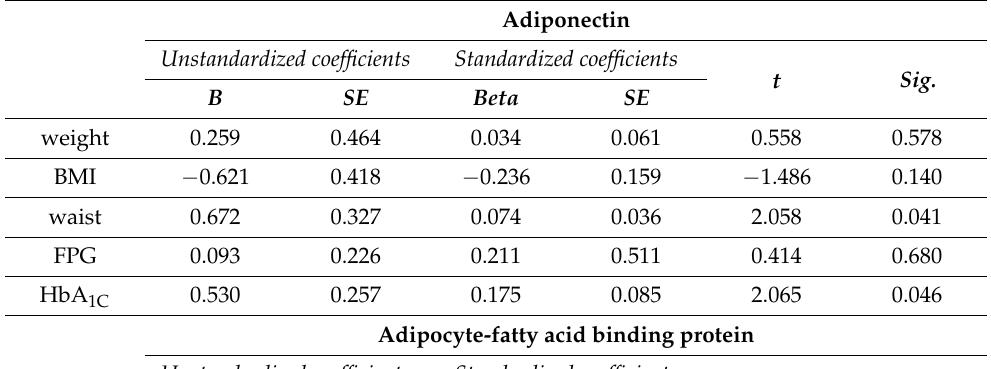
Table 3. Multivariate linear regression analysis of independent factors affecting adiponectin, adipocyte fatty acid-binding protein, and fibroblast growth factor-19 as dependent